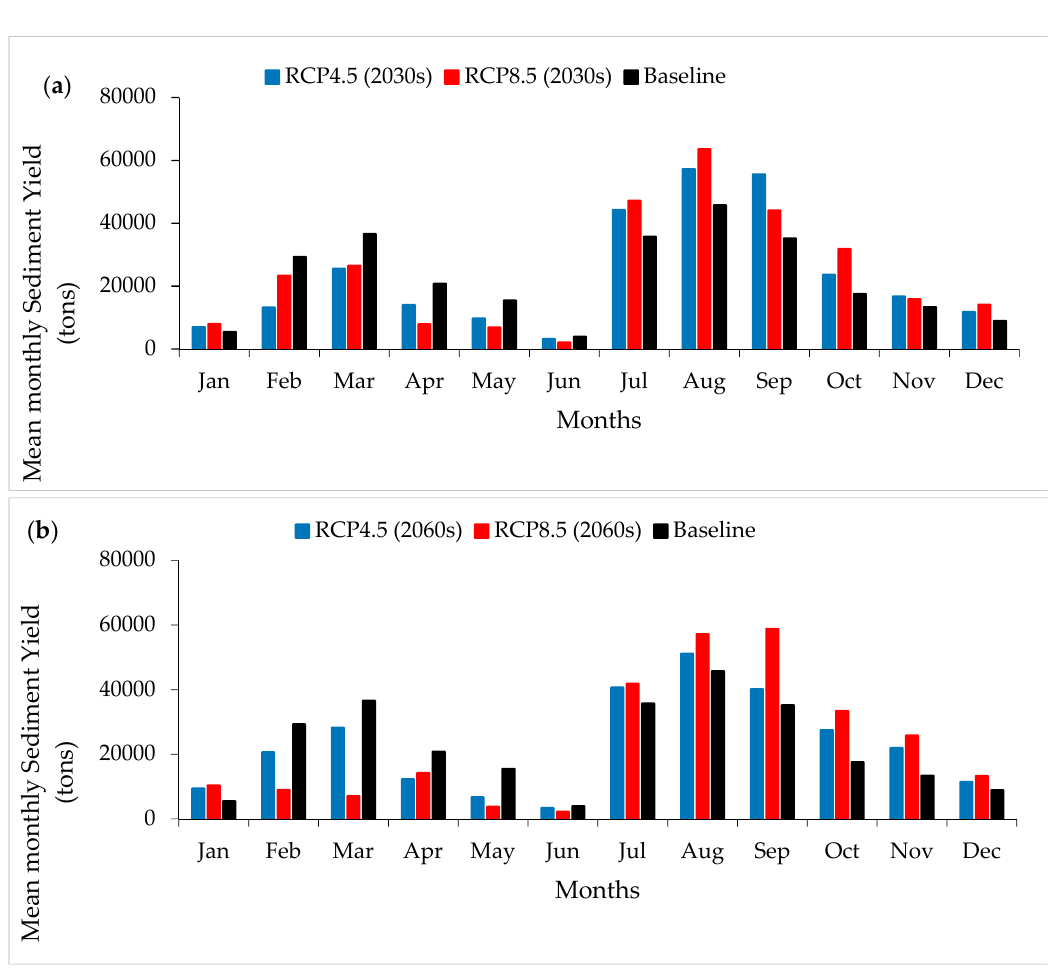
Figure 13. Mean monthly sediment yield in the 2030s ( a ) and the 2060s ( b ) projected at the outlet of the Logiya watershed.